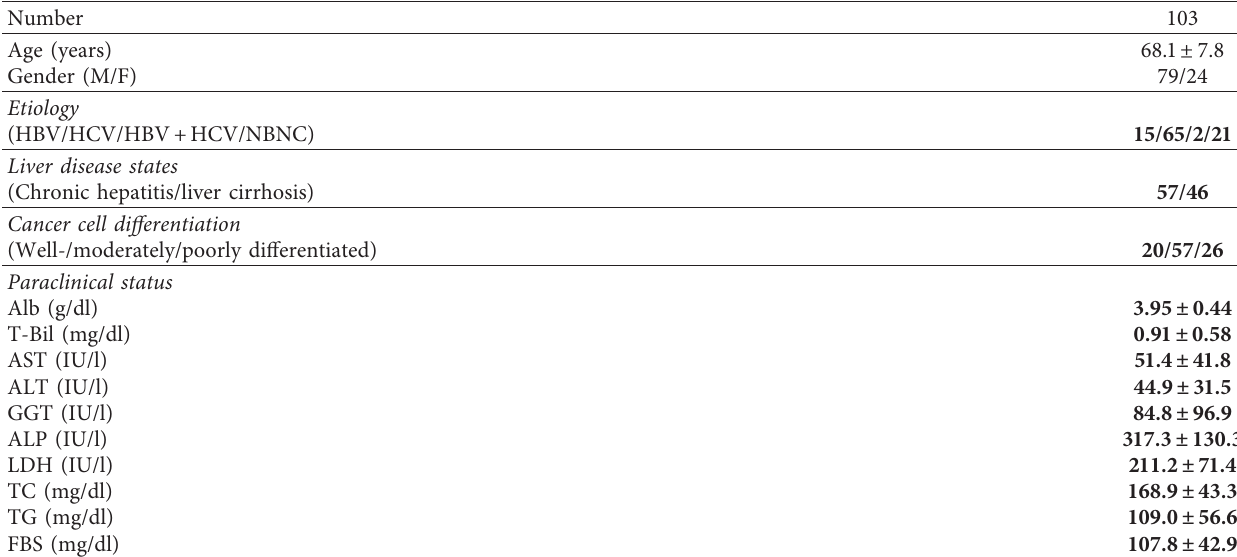
Table 1: Clinical characteristics of the patients with